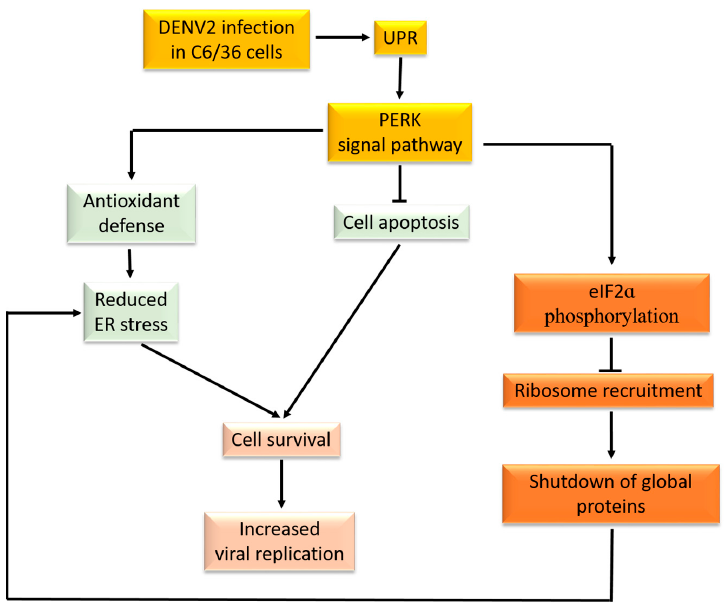
Figure 10. A schematic model of dengue 2 virus (DENV2) infection in mosquito cells, showing the PERK-mediated modulating web involved in dynamic protein synthesis, cell survival and virus